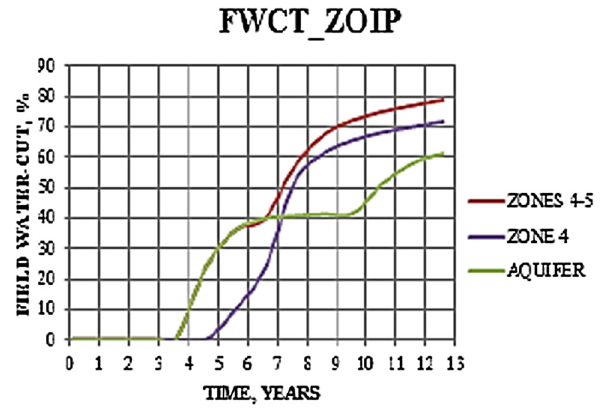
Fig. 14 Plot of field oil production rate versus time for different ZoIP scenarios for the five-spot waterflood